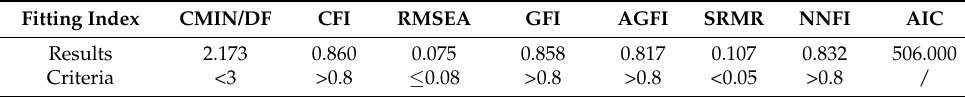
Table 5. Structural equation model goodness-of-fit tests.